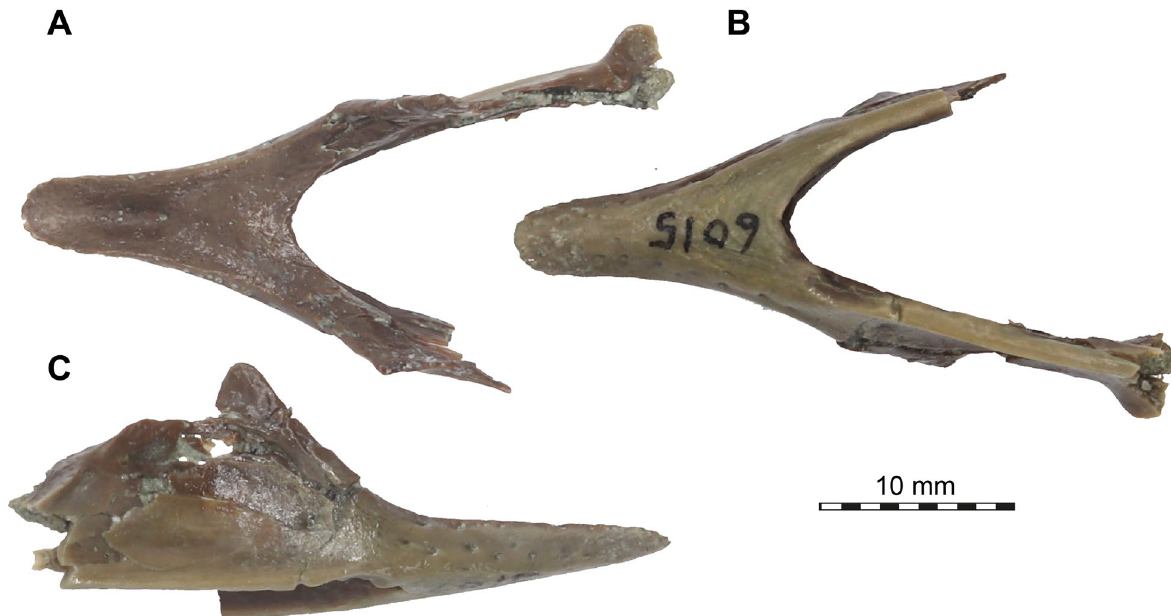
Fig. 2 Photographs of the mandible of Plastomenus thomasii (AMNH FR 6015). A dorsal view. B ventral view. C right lateral view. Note that the posterior part of the left mandibular ramus is preserved, but broken from the main part of the fossil. See 3D renderings for complete